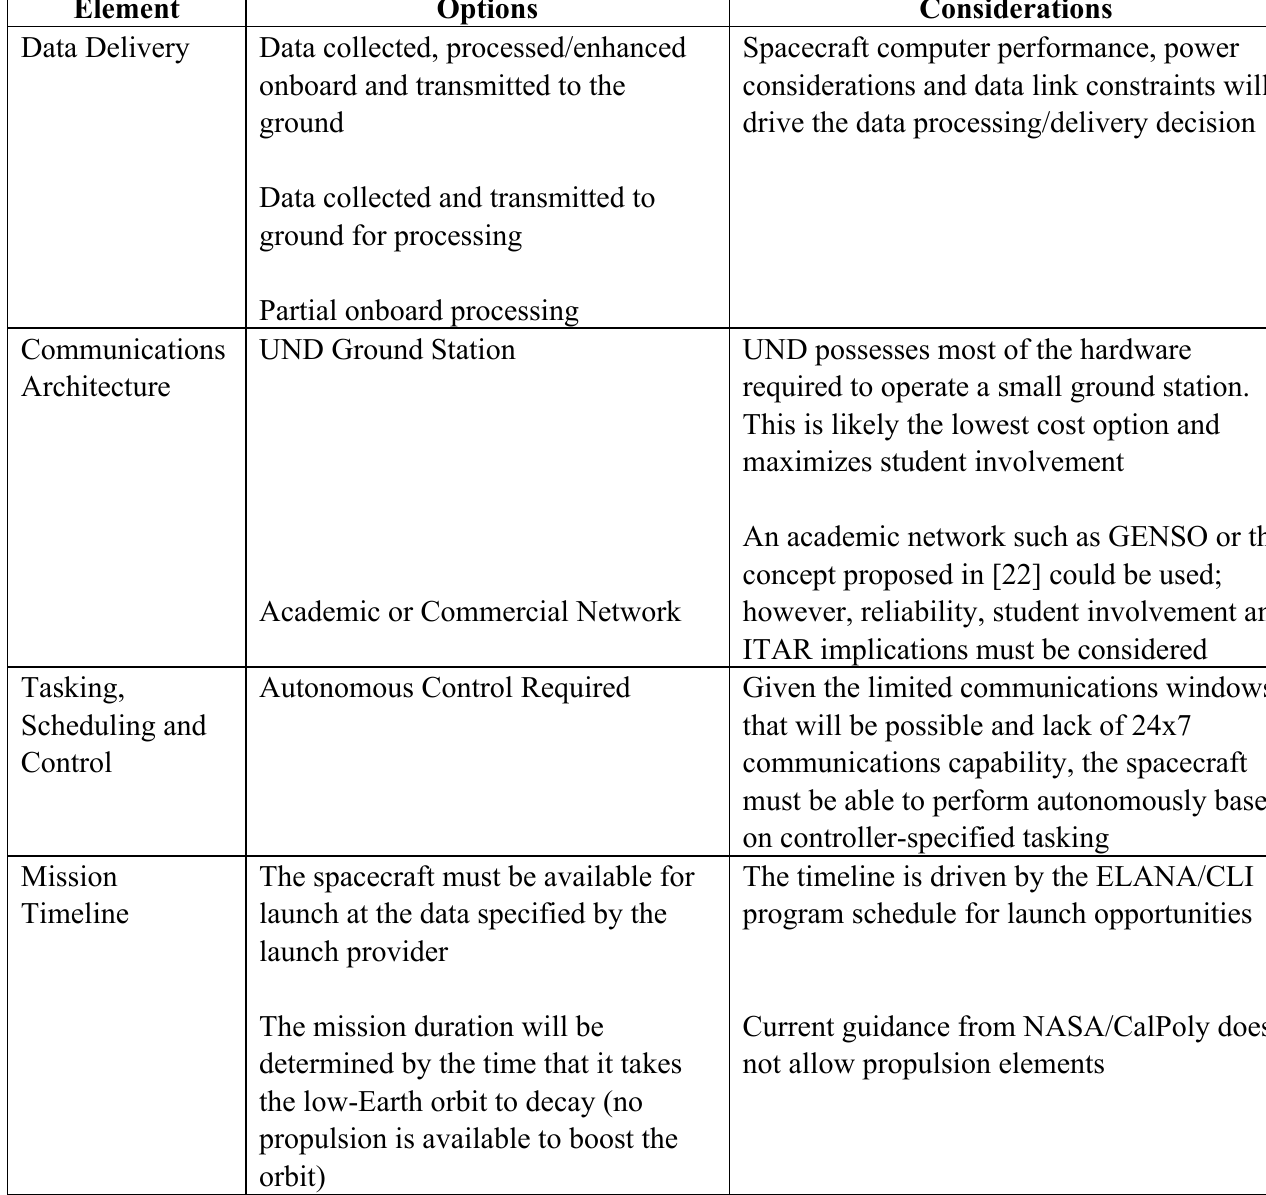
Table 1. Mission Concept of Operations Solution Space.